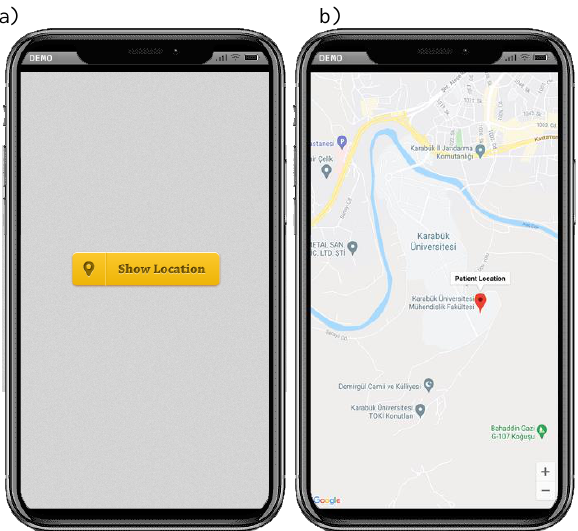
Figure 5. The screenshots of the developed mobile application.